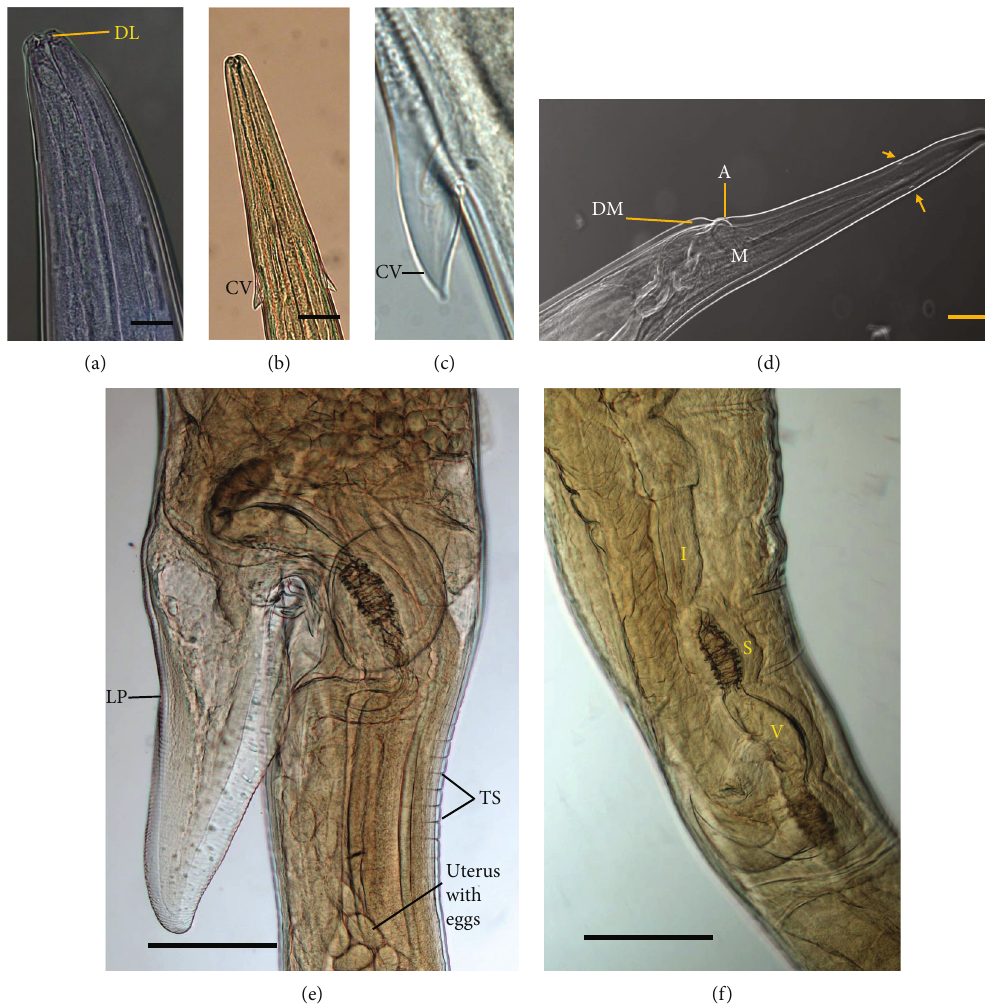
Figure 1: (a) Anterior end; dorsal lancet (DL). (b) and (c) Cervical papillae (CV). (d) Posterior end; anus (A); phasmids (arrow); dorsal rim cover the anus (DM); muscle (M; scale bar 50 μ m). (e) Linguiform process (LP); transverse cuticle striations (TS). (f) I: anterior infundibulum, S: anterior sphincter, and V: vestibular (scale bar 200 μ